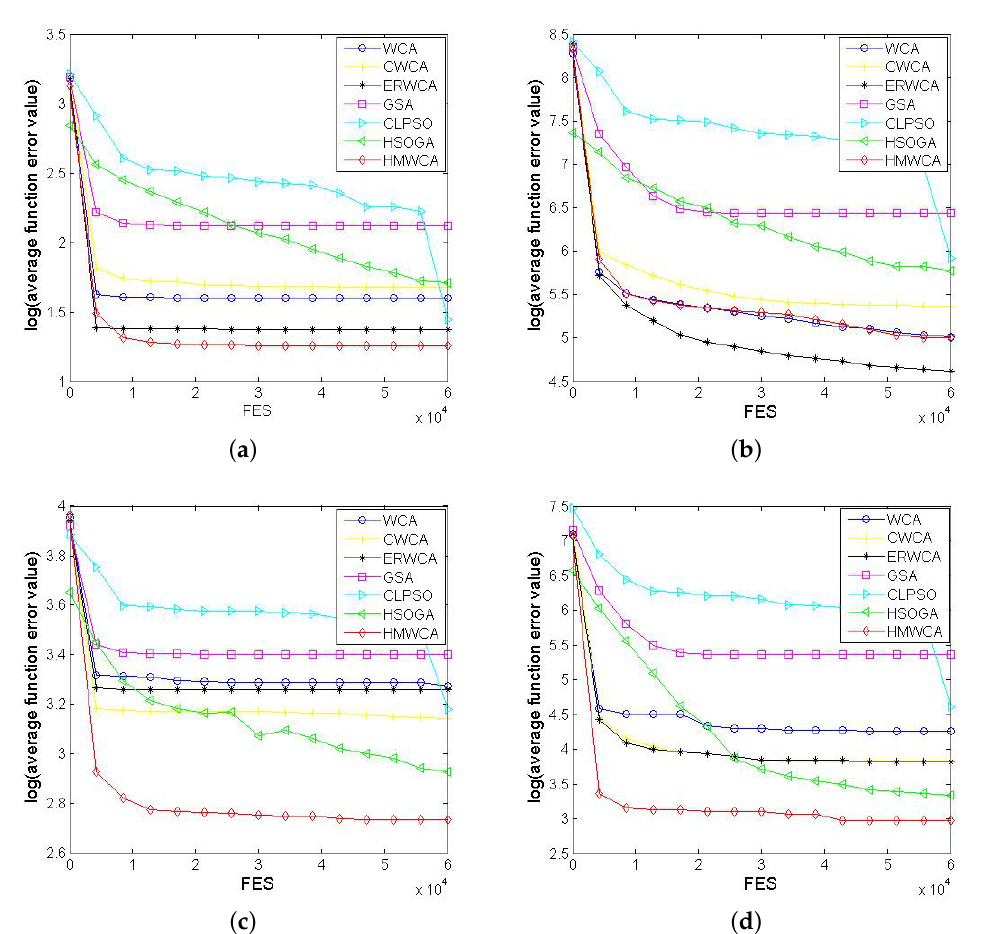
Figure 2. The evolution curves of the seven studied algorithms for functions ( a ) f 19 , ( b ) f 21 , ( c ) f 28 , ( d ) f 30 with D =